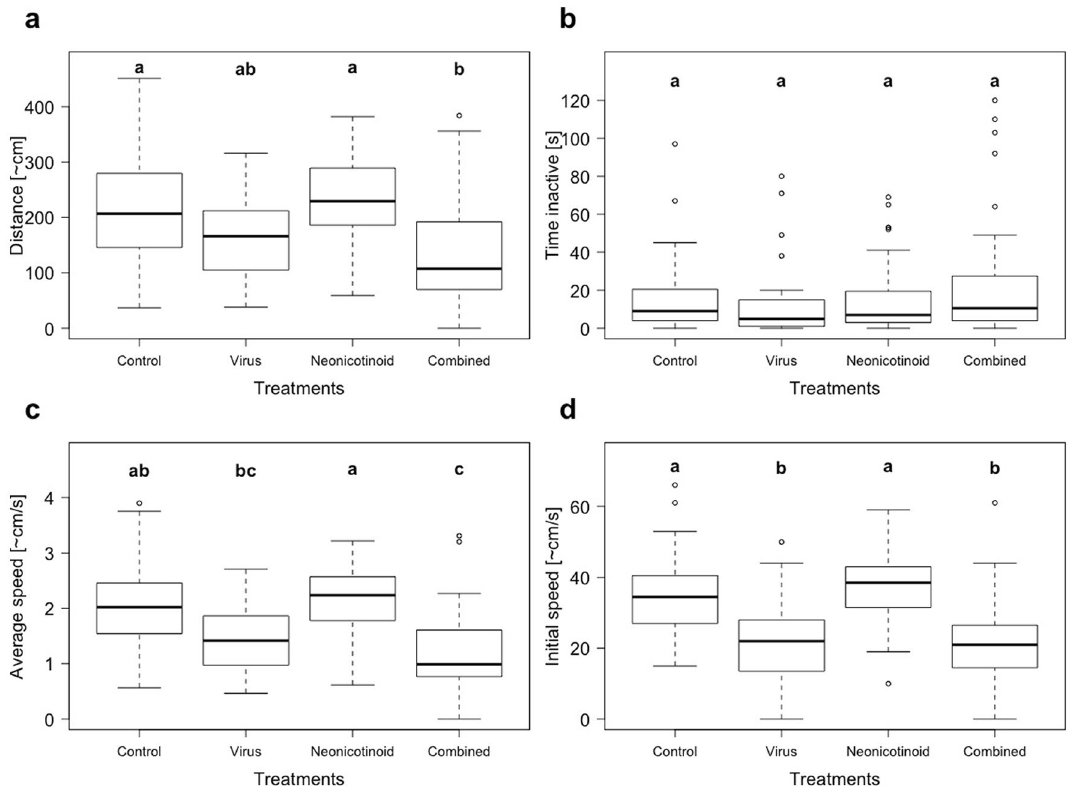
Figure 3. Behavioural assay. Movement analysis of Lasius niger workers from four different treatment groups (controls, neonicotinoid = chronic exposure to thiamethoxam (30 ppb), virus = feeding regime with Acute bee paralysis virus (ABPV), combined = exposure to thiamethoxam and ABPV) filmed for 120 s in a movement arena: ( a ) Estimated total distance covered, ( b ) amount of time the workers were inactive, ( c ) Average speed and ( d ) initial movement speed i.e. covered distance during the first ten seconds of observation. Significant differences between treatment groups is indicated by different letters ( a , b ; linear mixed effect modelling with post hoc Tukey correction, p <